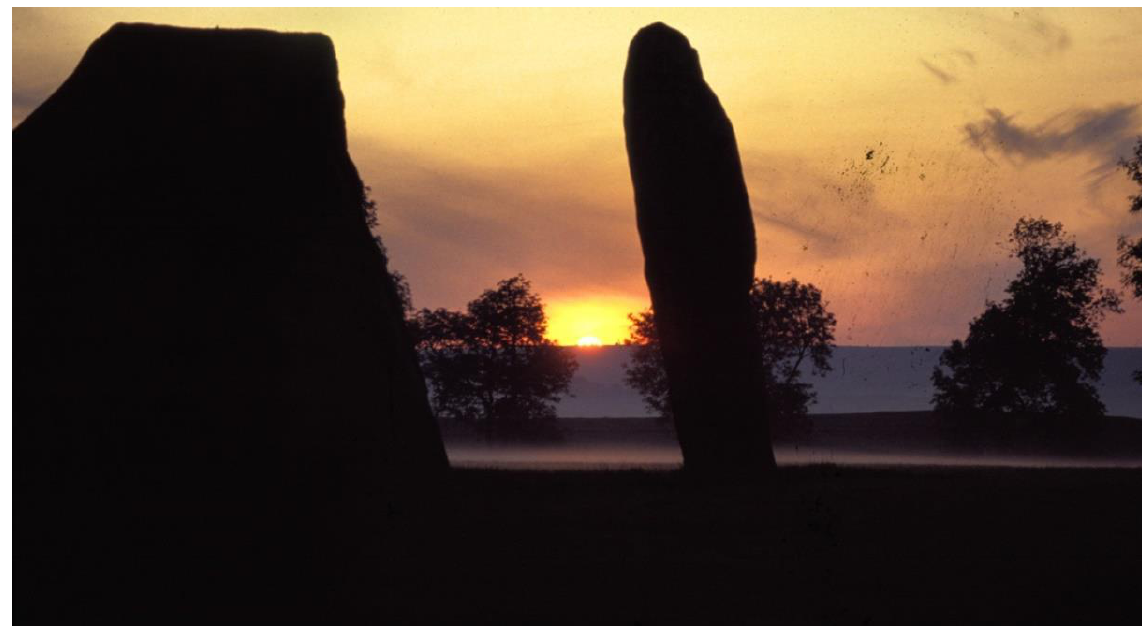
Figure 16. At the Avebury Cove looking north-east at the time of sunrise in midsummer week 1991. (Photograph by the author.)